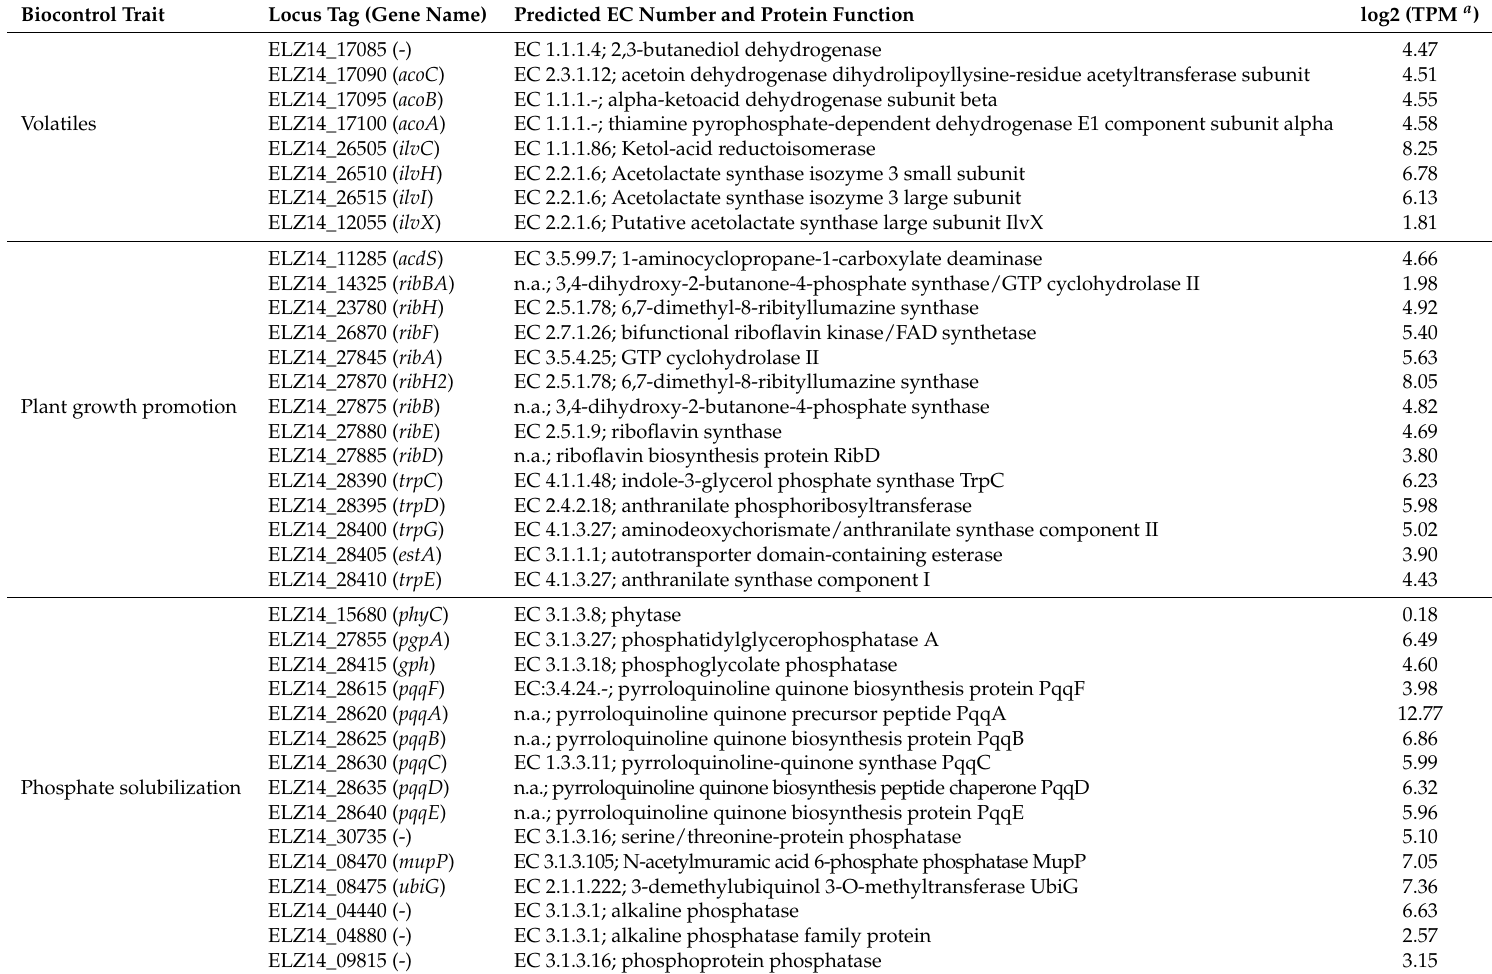
Table 6. Genetic biocontrol determinants of P. brassicacearum 3Re2-7—Induced systemic resistance & Plant growth promotion. Biocontrol